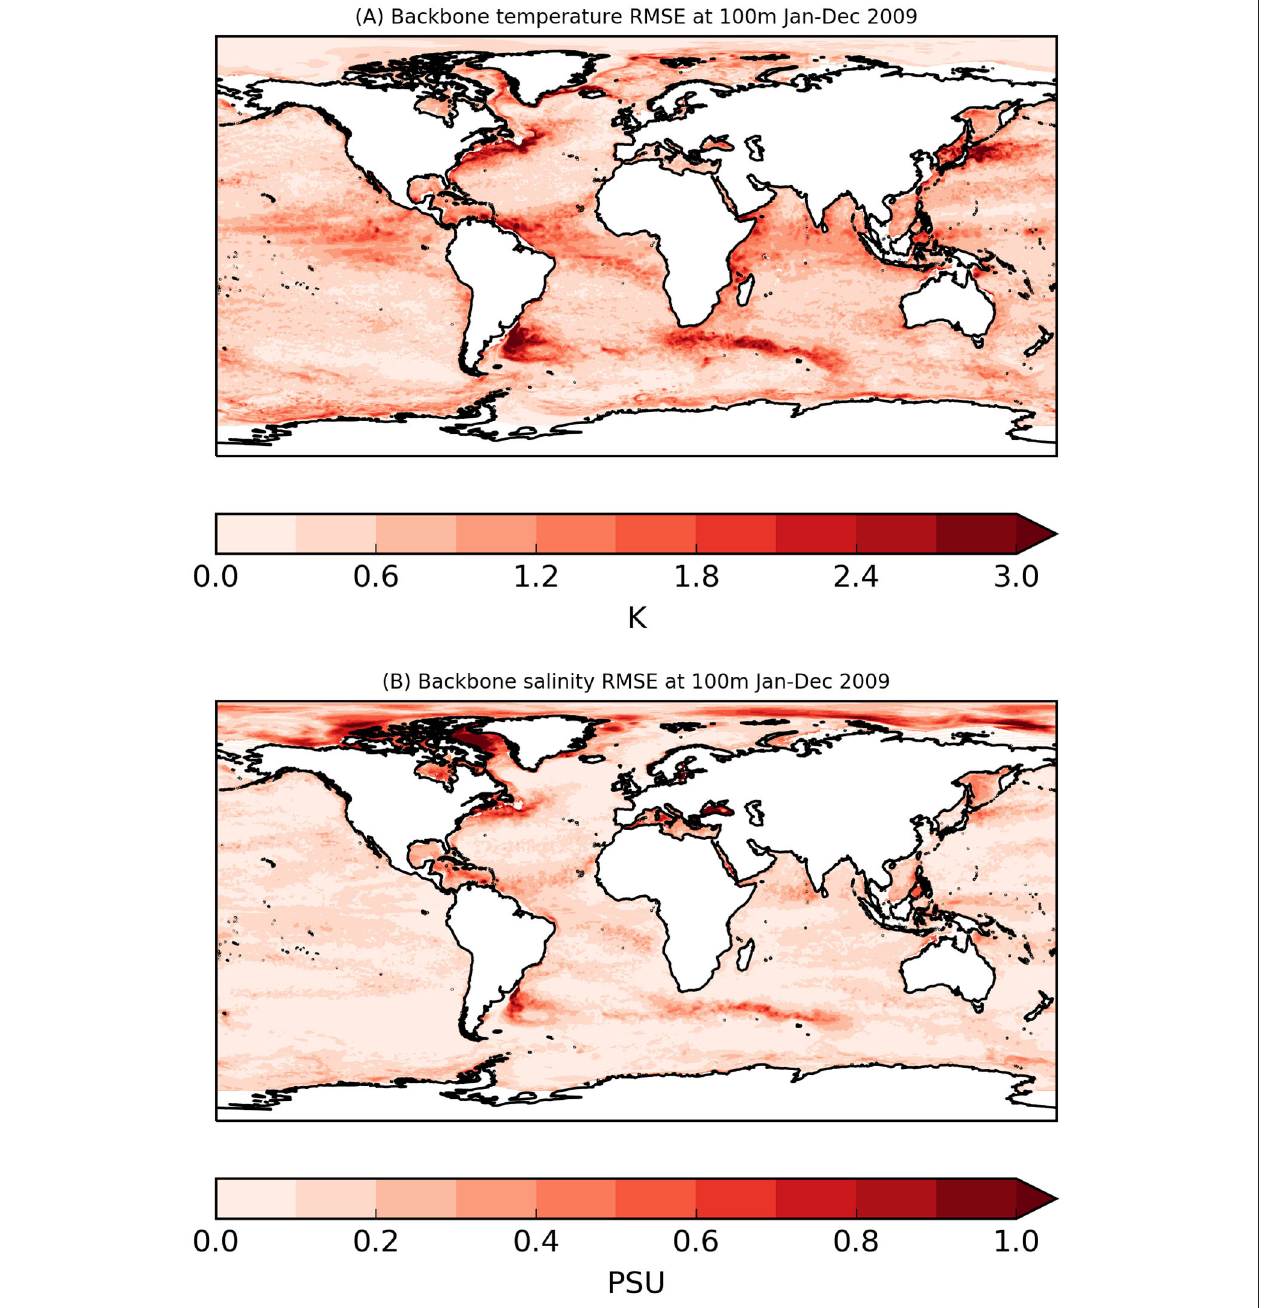
FIGURE 5 | The spatial map of annually averaged Backbone RMSE (relative to the Nature Run) for (A) temperature and (B) salinity fields at 100m depth.